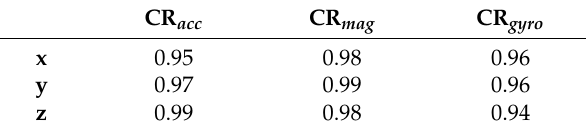
Table 1. The calibrated results of the sensor nodes.